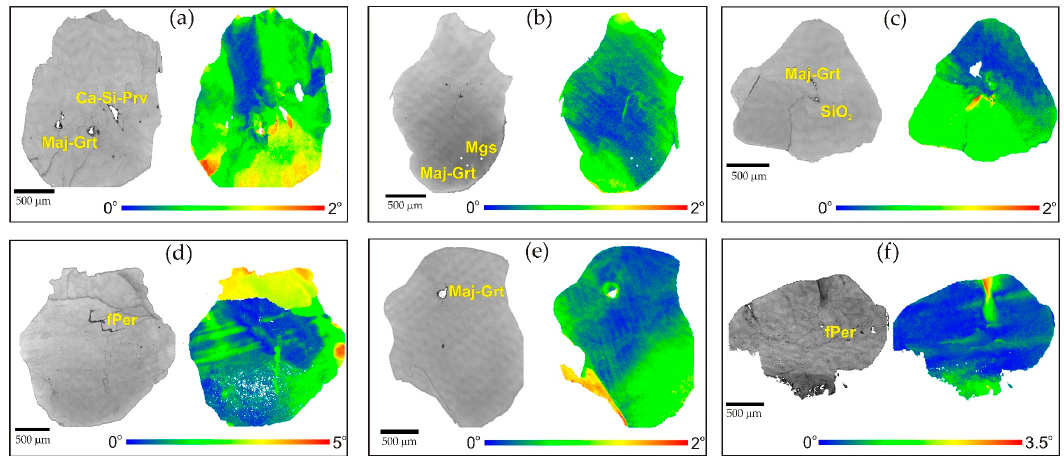
Figure 8. Misorientation patterns of super-deep diamonds from São-Luiz alluvial placers (Juina, Brazil). Electron backscatter diffraction (EBSD) maps over large parts of the polished plates showing a change in orientation. ( a ) SL-34; ( b ) SL-55; ( c ) SL-16; ( d ) SL-24; ( e ) C-2; ( f ) SL-82 (left—reflected light, right—EBSD image, bottom—misorientation degrees).